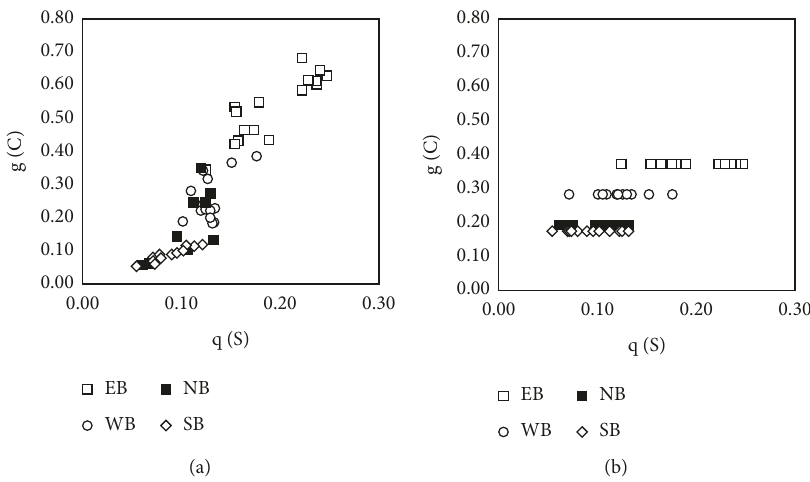
Figure 9: Variation of g/C with respect to q/S across cycles. (a) Proposed design. (b) Webster’s design.